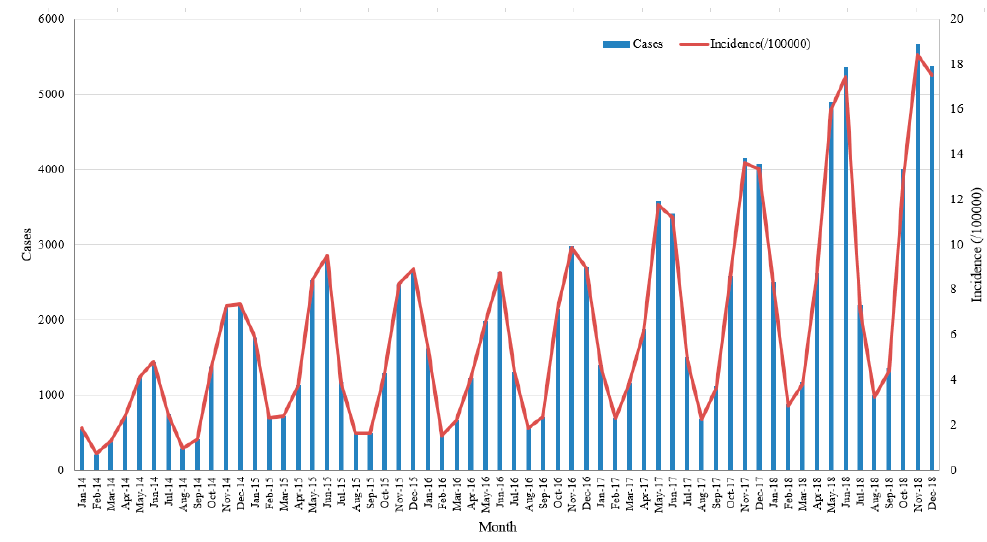
Figure 1. Monthly distribution of varicella in Chongqing from 2014 to 2018.